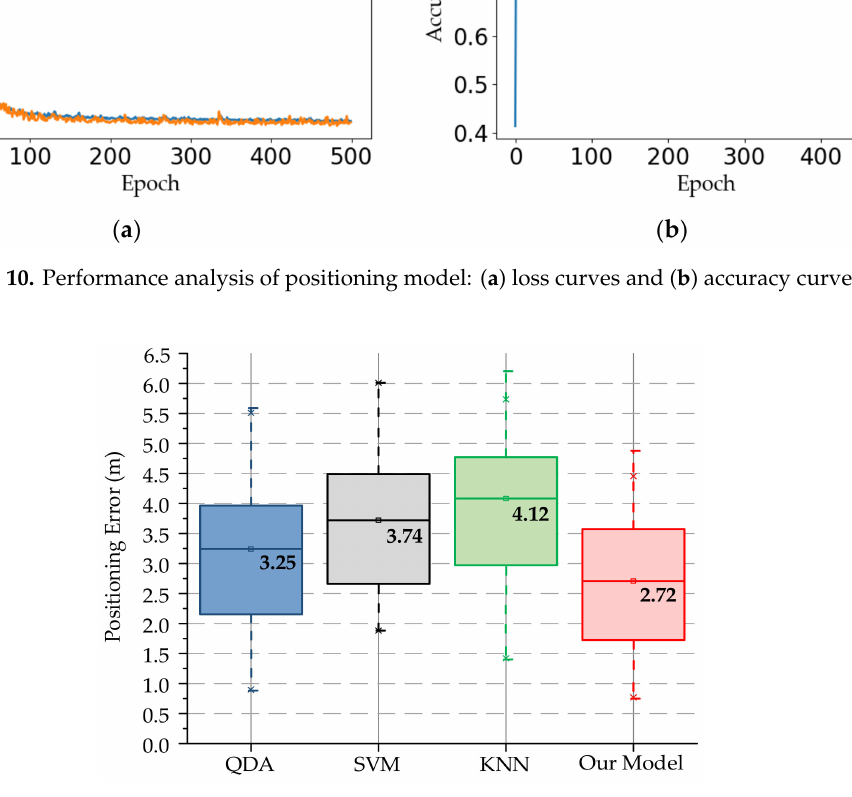
Figure 11. Comparative analysis of commonly used models. QDA, Quadratic Discriminant Analysis; SVM, Support Vector Machine; KNN, K Nearest